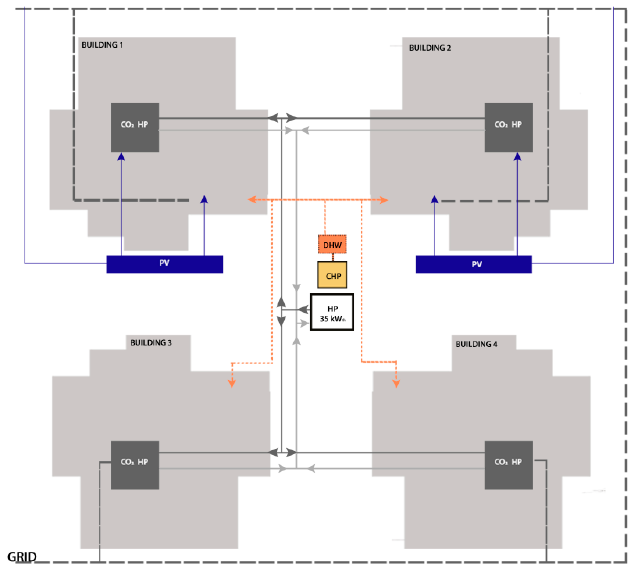
Figure 4. Hybrid energy system layout.